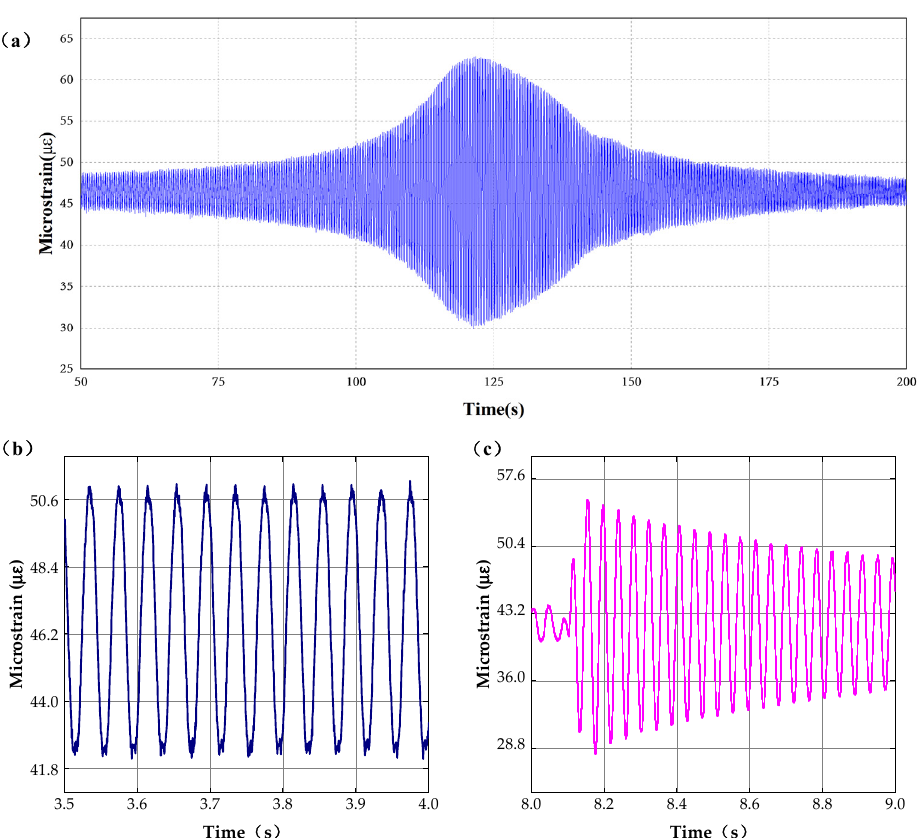
Figure 6. Dynamic experiments. ( a ) Results of frequency sweep experiments, ( b ) results of fixed frequency experiments, and ( c ) results of upside-down vibration experiments.